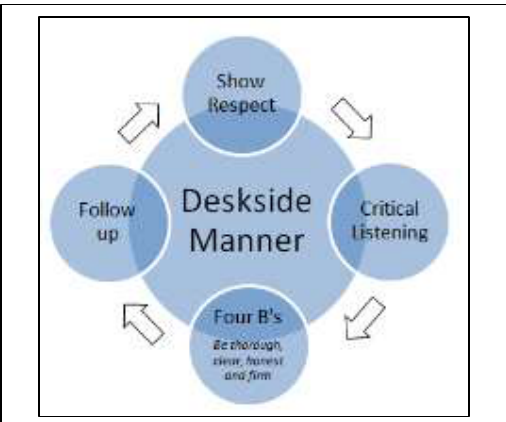
Figure 1: A framework for deskside